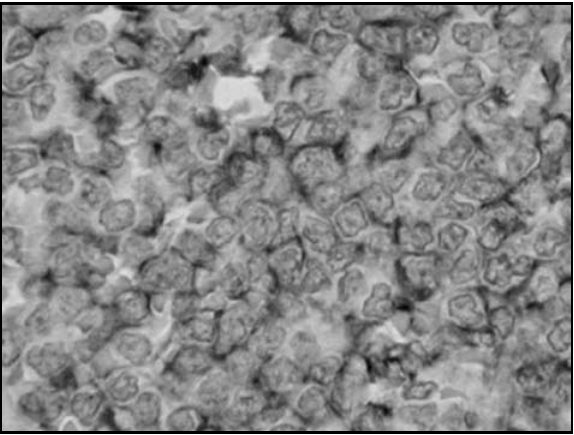
Figura 6 (caso 2) – Imunorreatividade nas membranas celulares de células neoplásicas para CD56